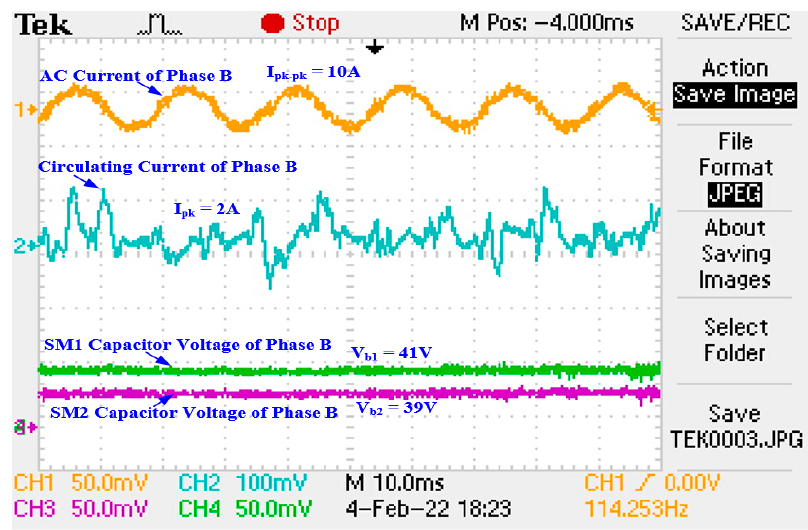
Figure 21. Result validation of Figure 17 with Opal-RT.